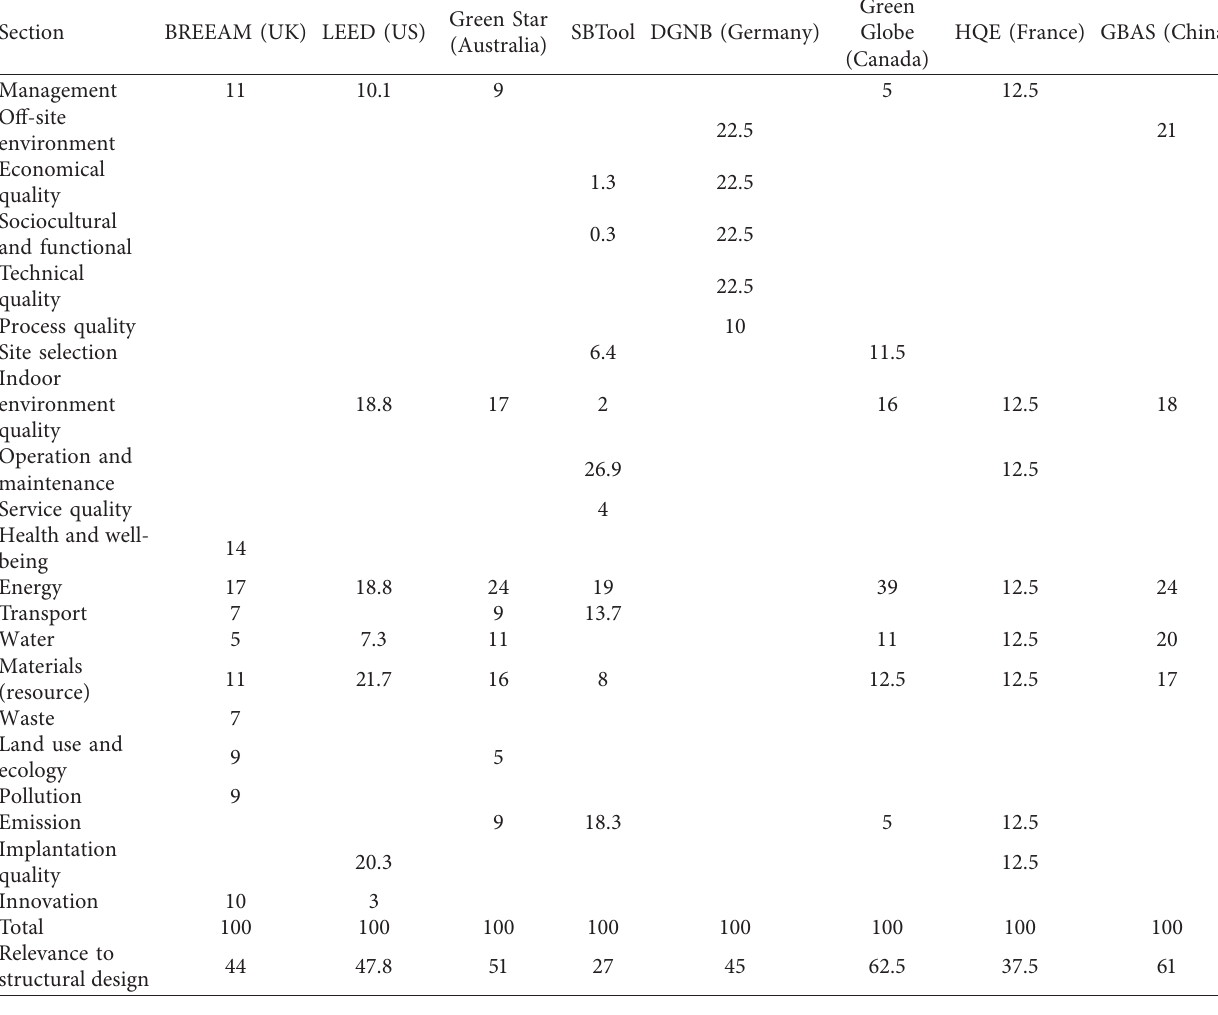
Table 3: Summary of the sustainable rating systems for building design (%).